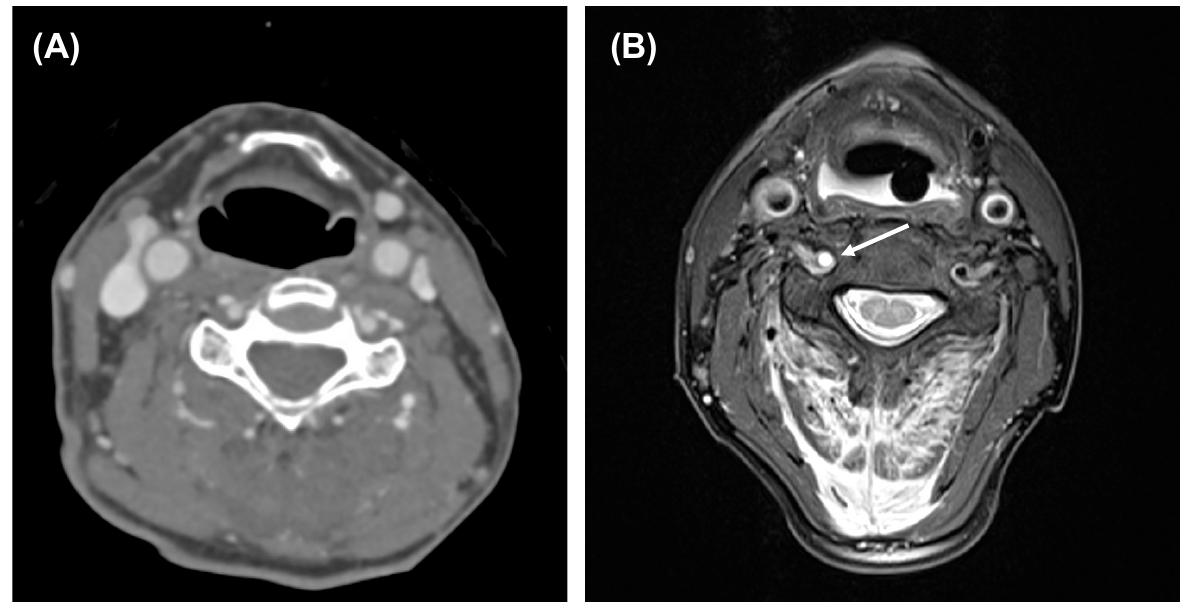
Figure 1. CT and MRI of a 67-year-old male after a car accident. ( A ) CT including CT-A revealed a fracture of C2. ( B ) Additional MRI showed a dissection of the right vertebral artery (arrow; proton density image with fat-saturation), progressed in the meantime from a smaller injury not detectable in CT-A. Furthermore, MRI showed additional fractures of C4 and C5 and a myelon damage level C2.